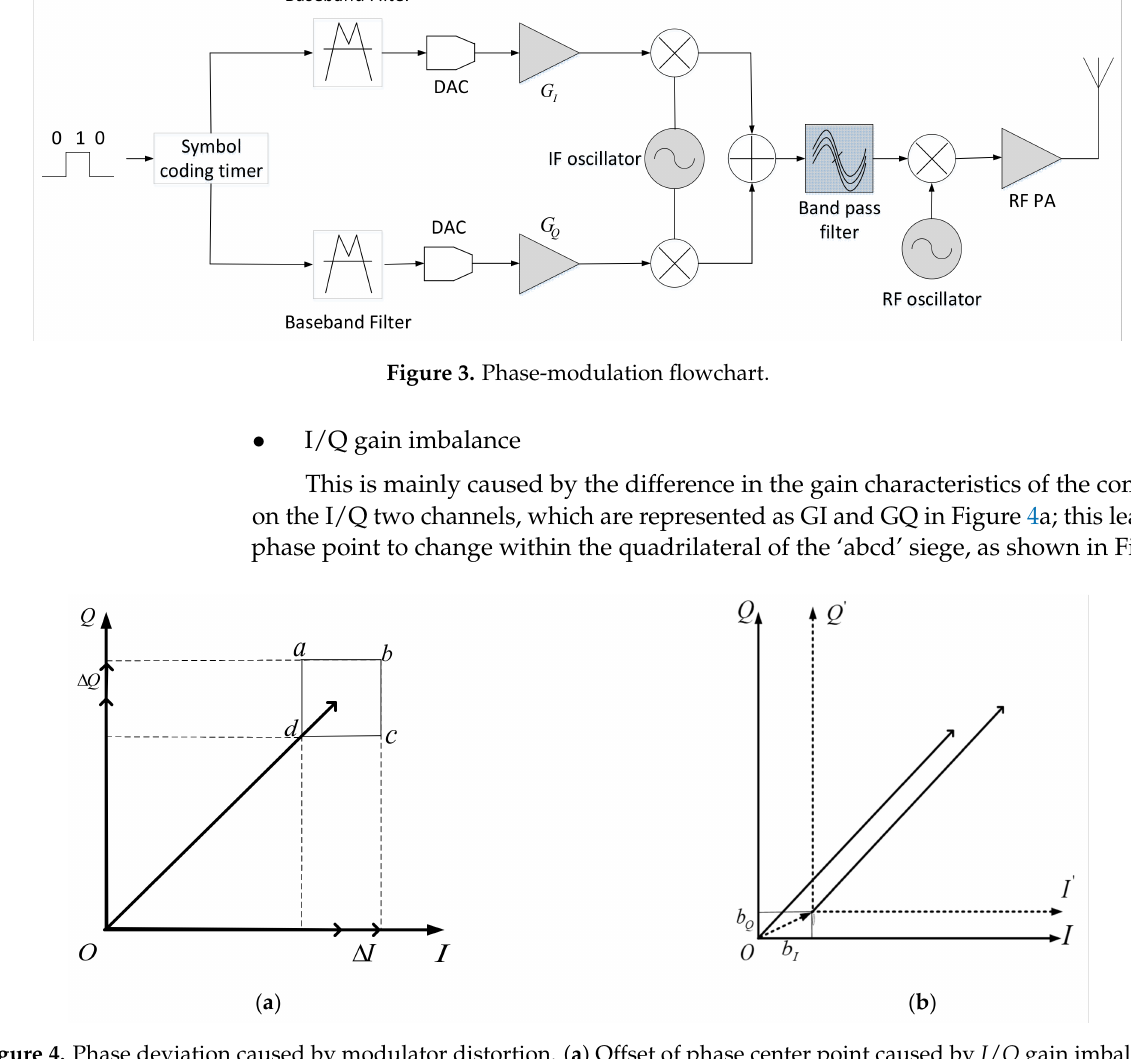
Figure 4. Phase deviation caused by modulator distortion. ( a ) Offset of phase center point caused by I / Q gain imbalance; ( b ) offset of origin of phase coordinate caused by DC